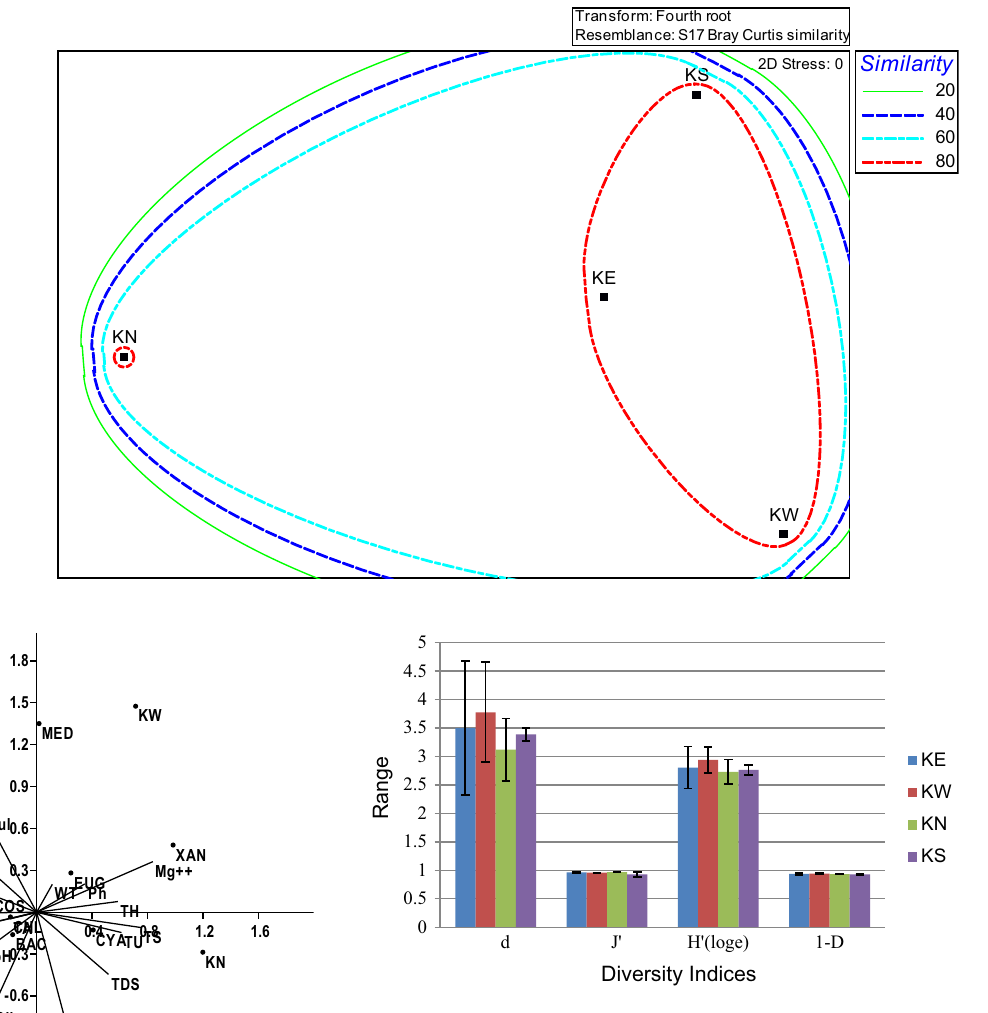
Fig. 7 Station-wise diversity indices of Kailash Khal ,